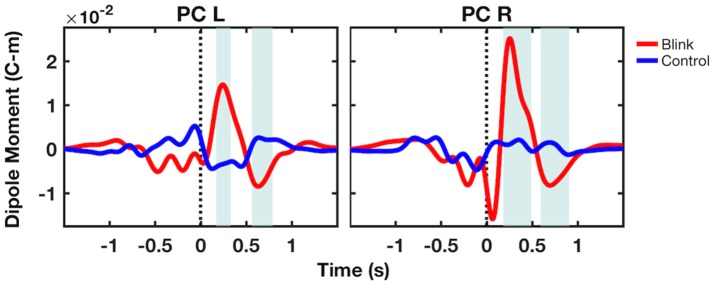
Grand-averaged virtual electrode time course activity from the bilateral precuneus. Shaded regions denote windows of significant difference between the blink and control conditions (p < 0.05). Black dotted line denotes T0. PC, precuneus; L, left; R, right.